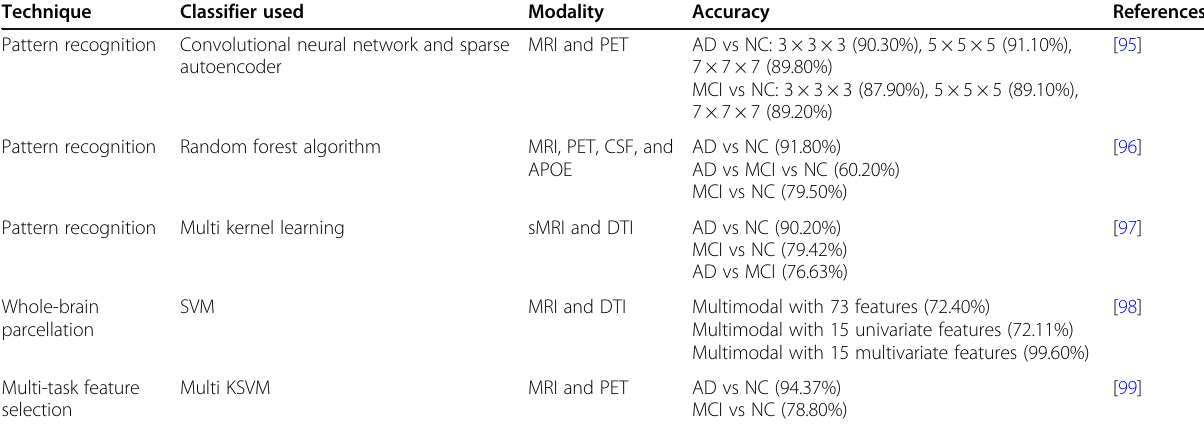
Table 2 Use of SVM classifier for AD diagnosis using different multimodal imaging scans